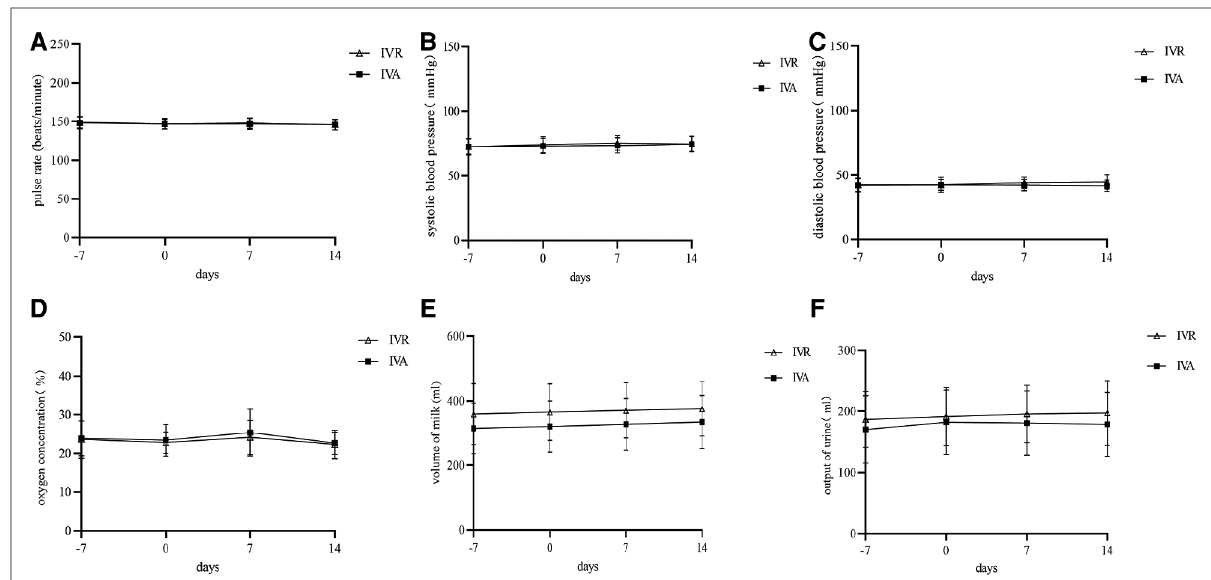
FIGURE 4 Comparison of parameters other than BW gain before and after treatment in the two groups. A-F , Changes in pulse rate ( A ), systolic blood pressure ( B ), diastolic blood pressure ( C ), oxygen concentration ( D ), volume of milk ( E ), and output of urine ( F